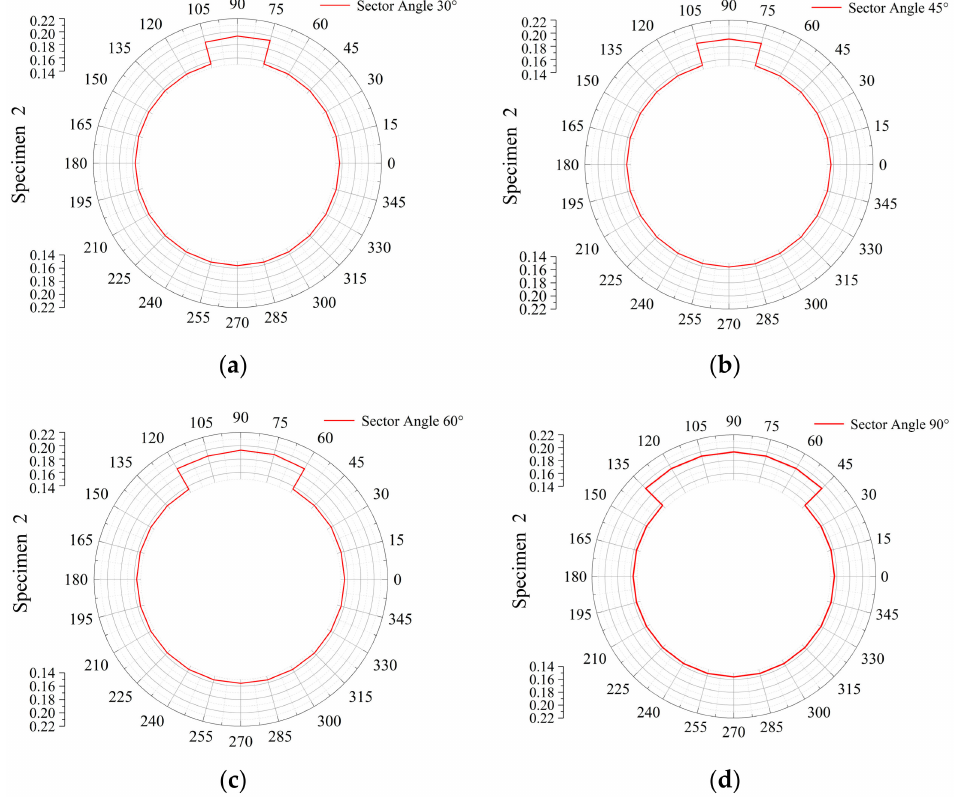
Figure 18. Calculation results of the frequency interval of specimen 2. ( a ) Sector angle 30 ◦ . (b) Sector angle 45 ◦ . ( c ) Sector angle 60 ◦ . ( d ) Sector angle 90 ◦ .